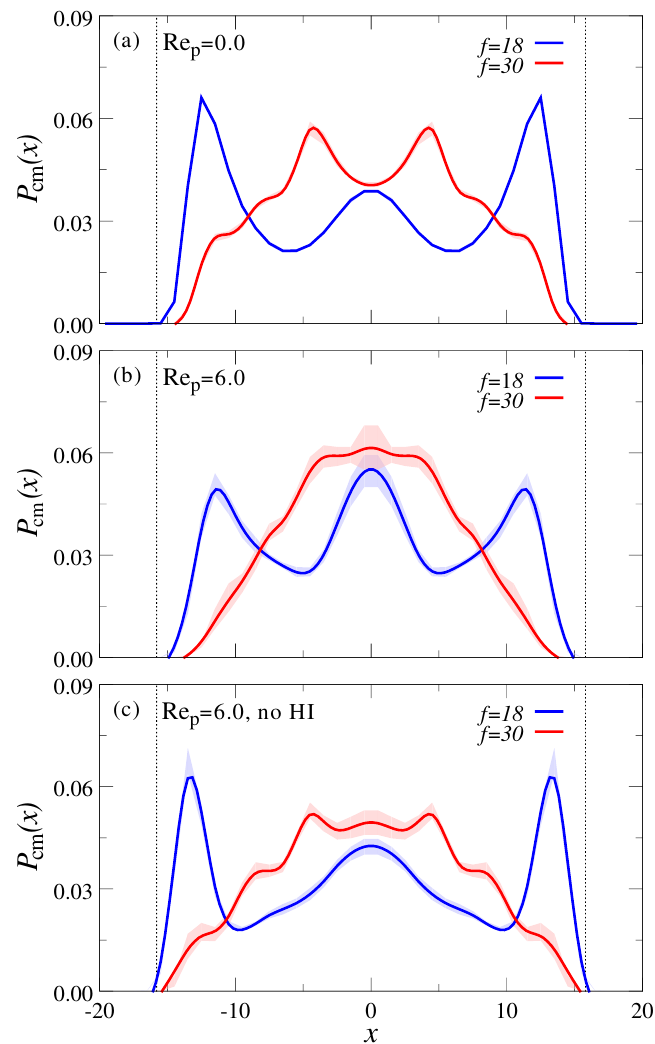
Figure 7. Center of mass probability distribution normal to the channel walls, P cm ( x ) , for a mixture of stars with f = 18 and f = 30 arms at ( a ) rest (Re p = 0) and ( b ) under flow (Re p = 6). Panel ( c ) shows the system under flow (Re p = 6), but with hydrodynamic interactions switched off. The volume fraction of polymers is fixed to Φ = 0.1 in all